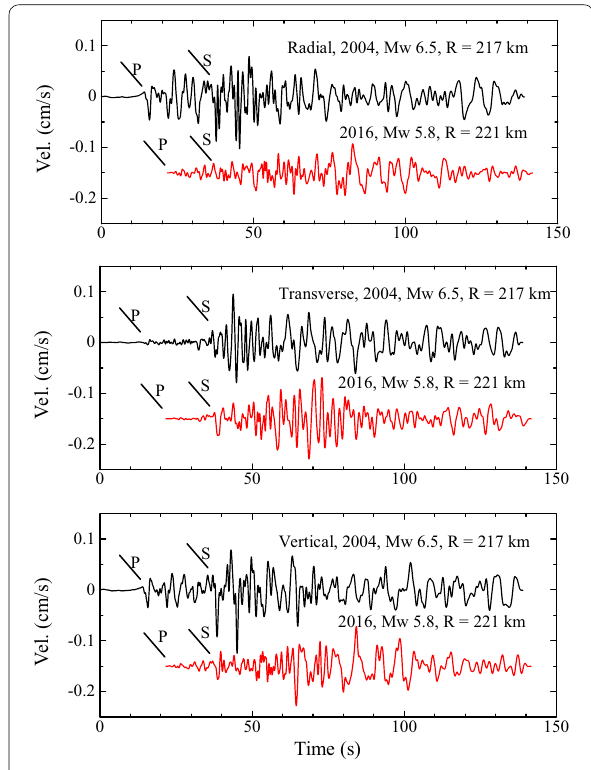
Fig. 7 Plot of radial (upper panel), transverse (middle panel), and vertical (lower panel) component velocity seismograms at site AICH15 (see Fig. 1 for location) for the 2004 (upper trace in each panel) and 2016 (lower trace in each panel) events. The seismograms were bandpass-filtered between 1 and 10 s. The seismograms are aligned to match the S-wave arrivals. The arrivals of P- and S-waves are indicated by the letters P and S, respectively. See Fig. 6 for the accelerograms at the site and Fig. 9 for a comparison of the adjusted PGAs and PGVs among the sites